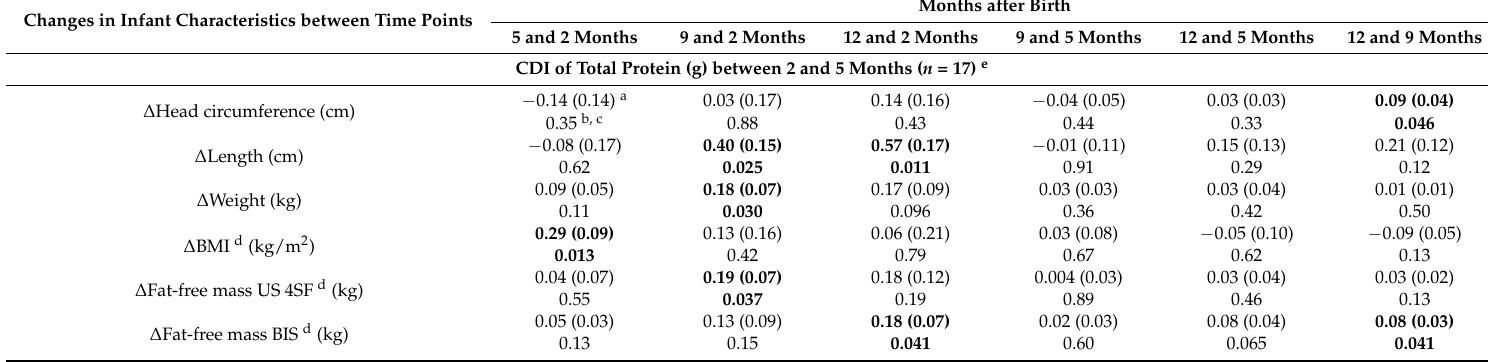
Table A5. Associations between calculated daily intakes of human milk total protein at given time points and changes in infant body composition between the time